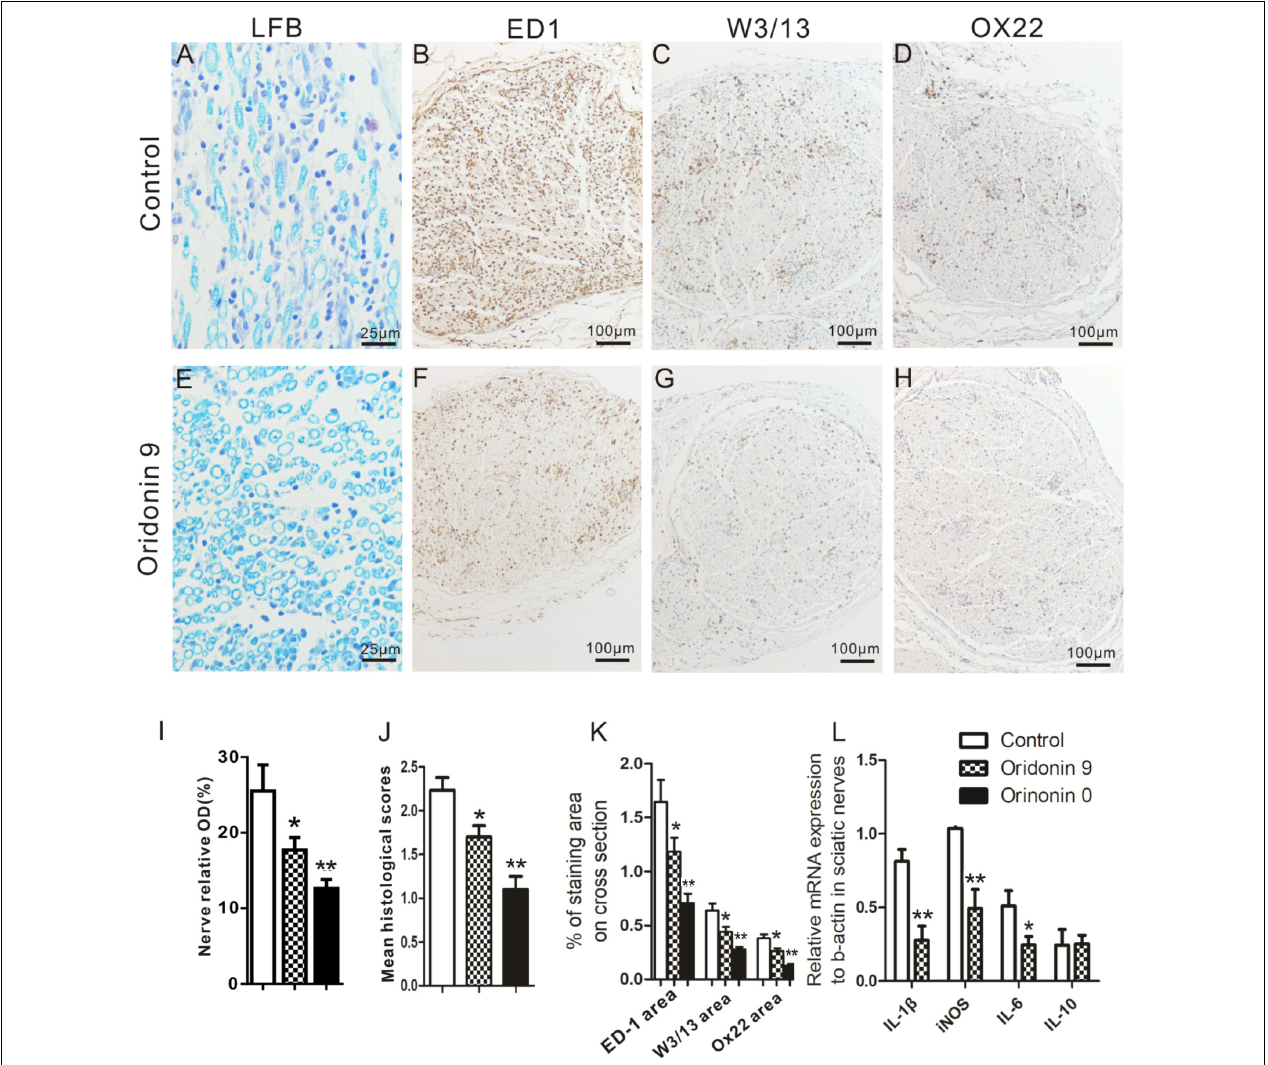
FIGURE 3 | Oridonin treatment attenuated local demyelination, inflammatory cell infiltration and inflammatory cytokines in sciatic nerves of EAN rats. Following preventive or therapeutic treatments, rats were sacrificed on Day 15 and sciatic nerves were taken for LFB and immunohistochemical staining or semi-quantitative PCR. Representative microphotos of LFB and IHC staining for control (A–D) or Oridonin treated (E–H) EAN rats are shown. Quantification of demyelination, mean histological scores and percentages of immune cells marker IR on cross sections were calculated as described in Materials and Methods. Preventive or therapeutic Oridonin treatments significantly reduced the demyelination levels; mean histological scores; percentages of ED1 (macrophages), W3/13 (pan-T cells) and OX22 (B cells) IR in sciatic nerves, compared to the control EAN rats (I–K) . (L) mRNA levels of IL-1 β , IL-6, iNOS and IL-10 in sciatic nerves of these EAN rats was analyzed by real-time PCR. Therapeutic Oridonin treatment significantly reduced mRNA levels of IL-1 β , IL-6 and iNOS in sciatic nerves, but did not change the mRNA level of IL-10 significantly. ∗ p < 0.05, ∗∗ p < 0.01 compared to the control group, n =